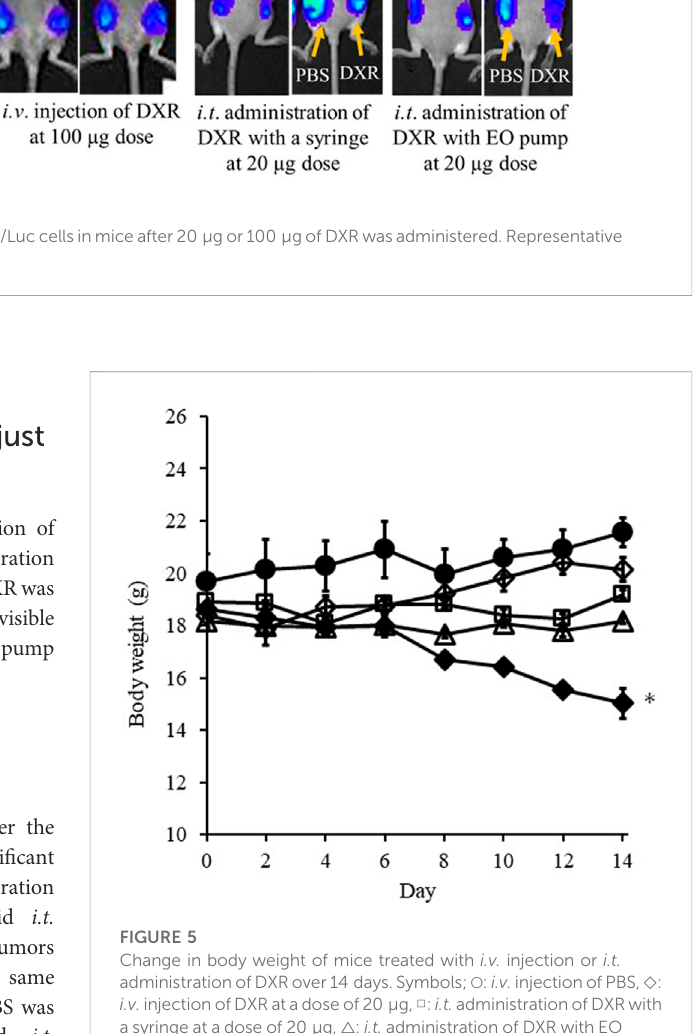
100 µg of DXR was administered. When i.t. administration of DXR was done to one of the two tumor tissues with a syringe or an EO pump, PBS was injected into the other tumor tissue with the same device.